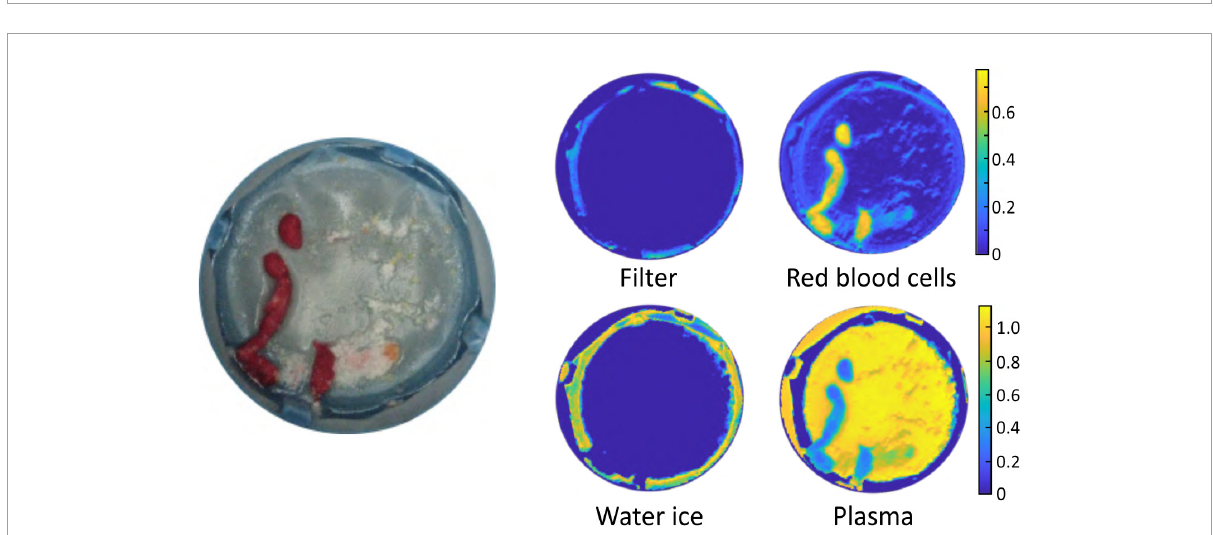
FIGURE5 Example output of the basis function fitting process. The image on the left is a photograph of the sample. The false colour images show the fitted contributions to the spectral image from the filter, water ice, plasma, and red blood cells.